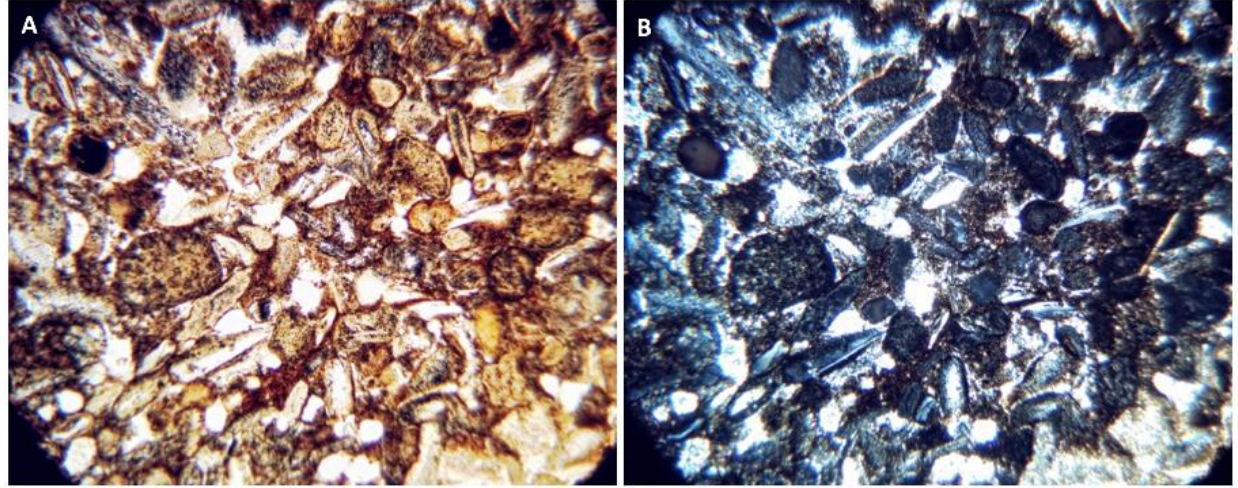
Figure A14. Plate E7: Photomicrograph of the fossil-rich phosphorite sample (HOP-5) under plain ( A ) and polarized ( B ) lights.